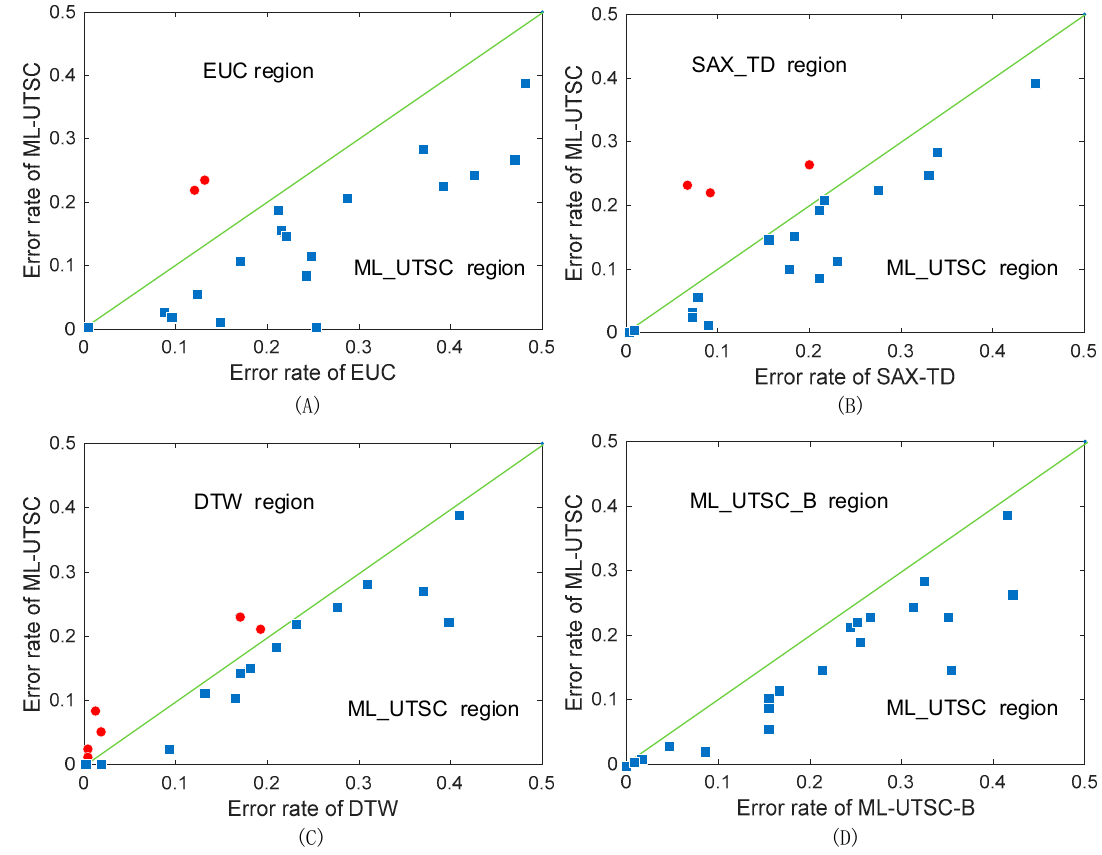
Figure 6. Scatter comparison of the five methods. ( A ) EUC VS. ML_UTSC; ( B ) SAX_TD VS.ML_UTSC; ( C )DTW VS. ML_UTSC; ( D ) ML_UTSC_B VS. ML_UTSC.